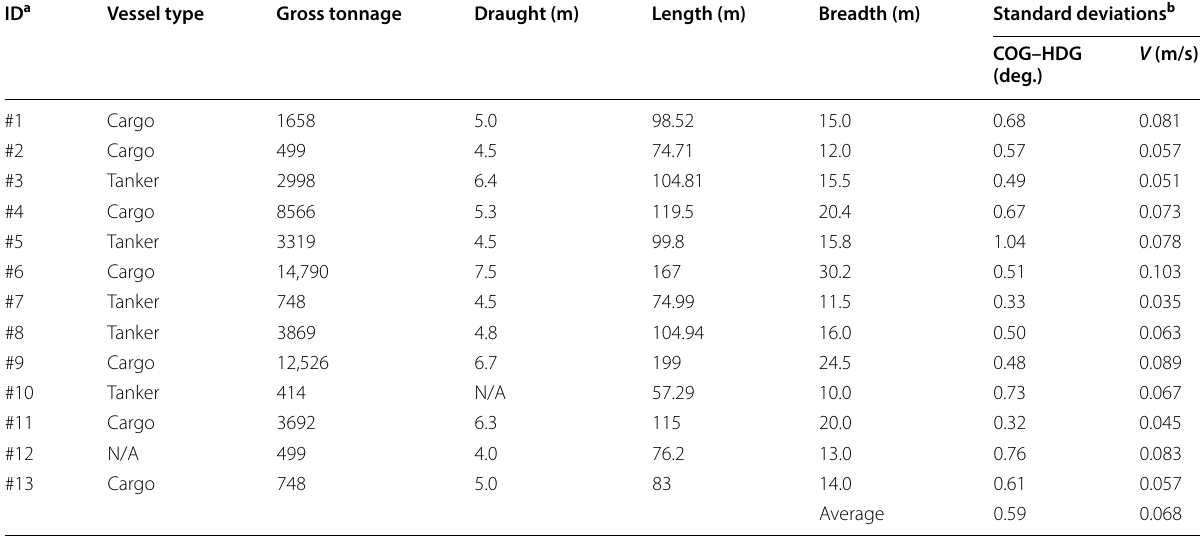
Table 1 Ship information and standard deviations derived from AIS data, except for gross tonnage, which was taken from MarineTraffic (https ://www.marin etraffi c.com/)